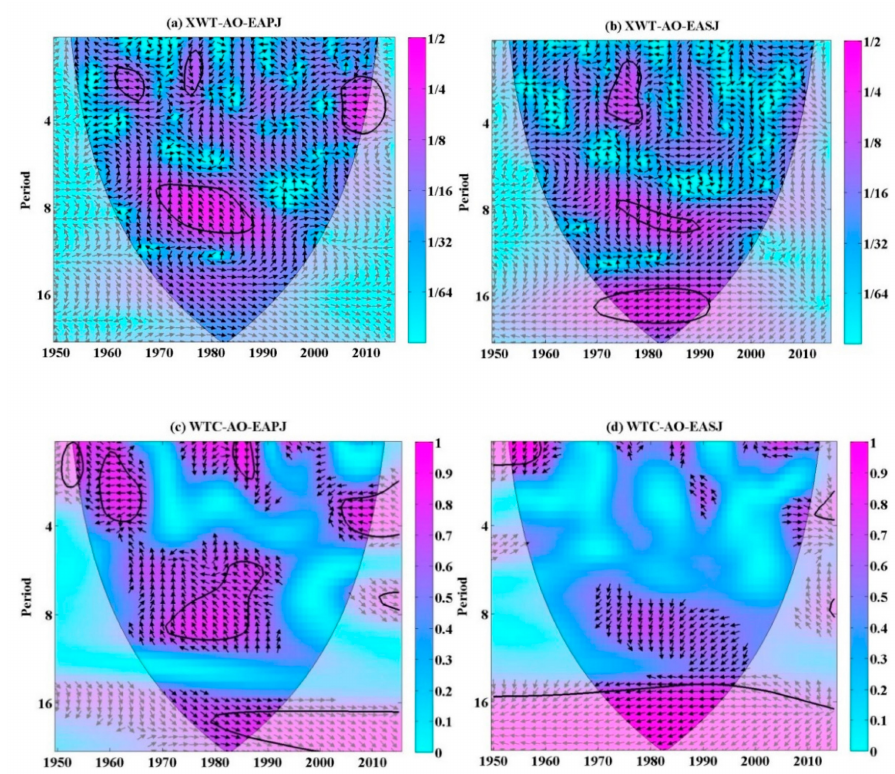
Figure 5. Cross-wavelet transform (XWT) of the ( a ) Arctic Oscillation and EAPJ and ( b ) Arctic Oscillation and EASJ, and the squared wavelet coherence (WTC) of the ( c ) Arctic Oscillation and EAPJ and ( d ) Arctic Oscillation and EASJ during the winters of 1950–2016. The thick black contour shows the 5% significance level against red noise, and the thin black line indicates the cone of influence where edge e ff ects might distort the picture shown in a lighter